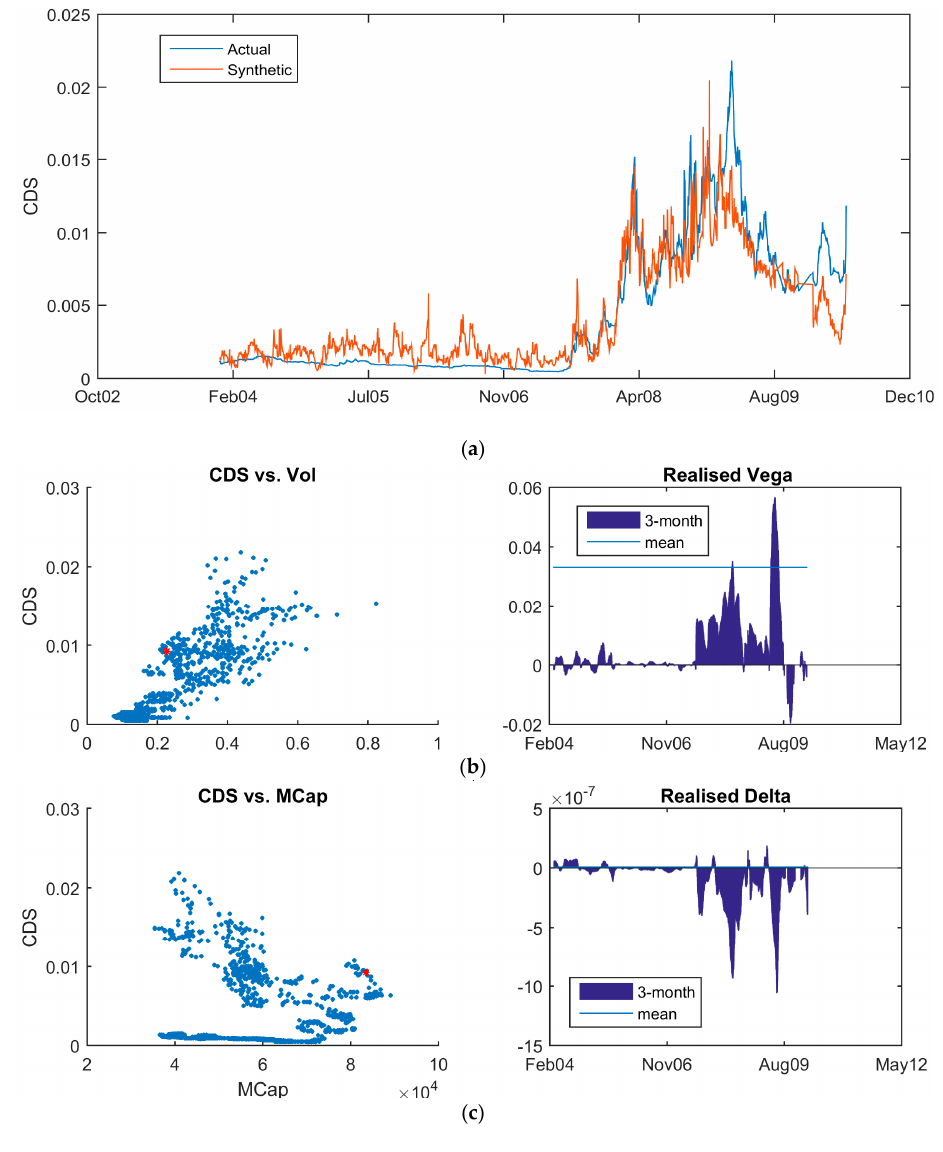
Figure 9. Commonwealth Bank of Australia (CBA) for: ( a ) synthetic CDS vs. traded five-year CDS from January 2004 until May 2010; ( b ) scatter plot of five-year CDS versus 10-delta implied put volatility with regressed three-month rolling hedge ratio and mean hedge ratio from March 2010; ( c ) scatter plot of five-year CDS versus market capitalization with regressed three-month rolling hedge ratio and mean hedge ratio from March